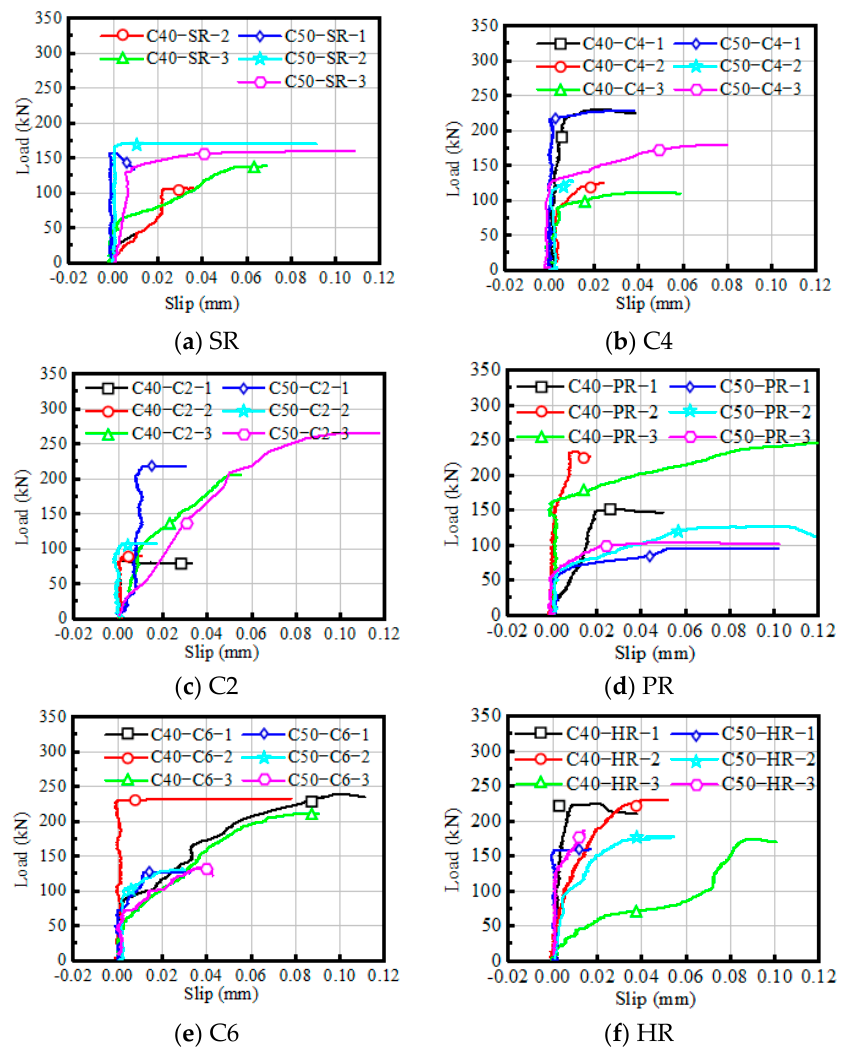
Figure 14. Relation between the load and the interface slip.